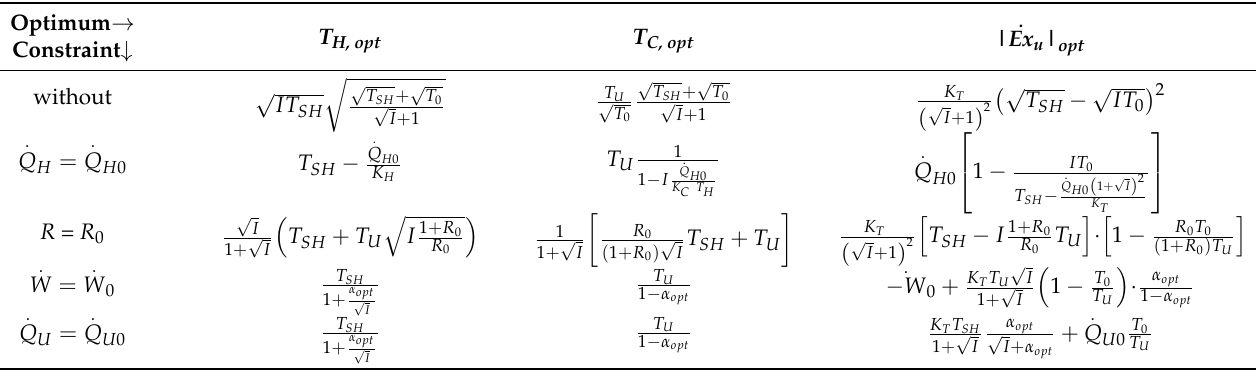
Carnot CHHP system optimization with constraints by using the irreversibility ratio ( I )